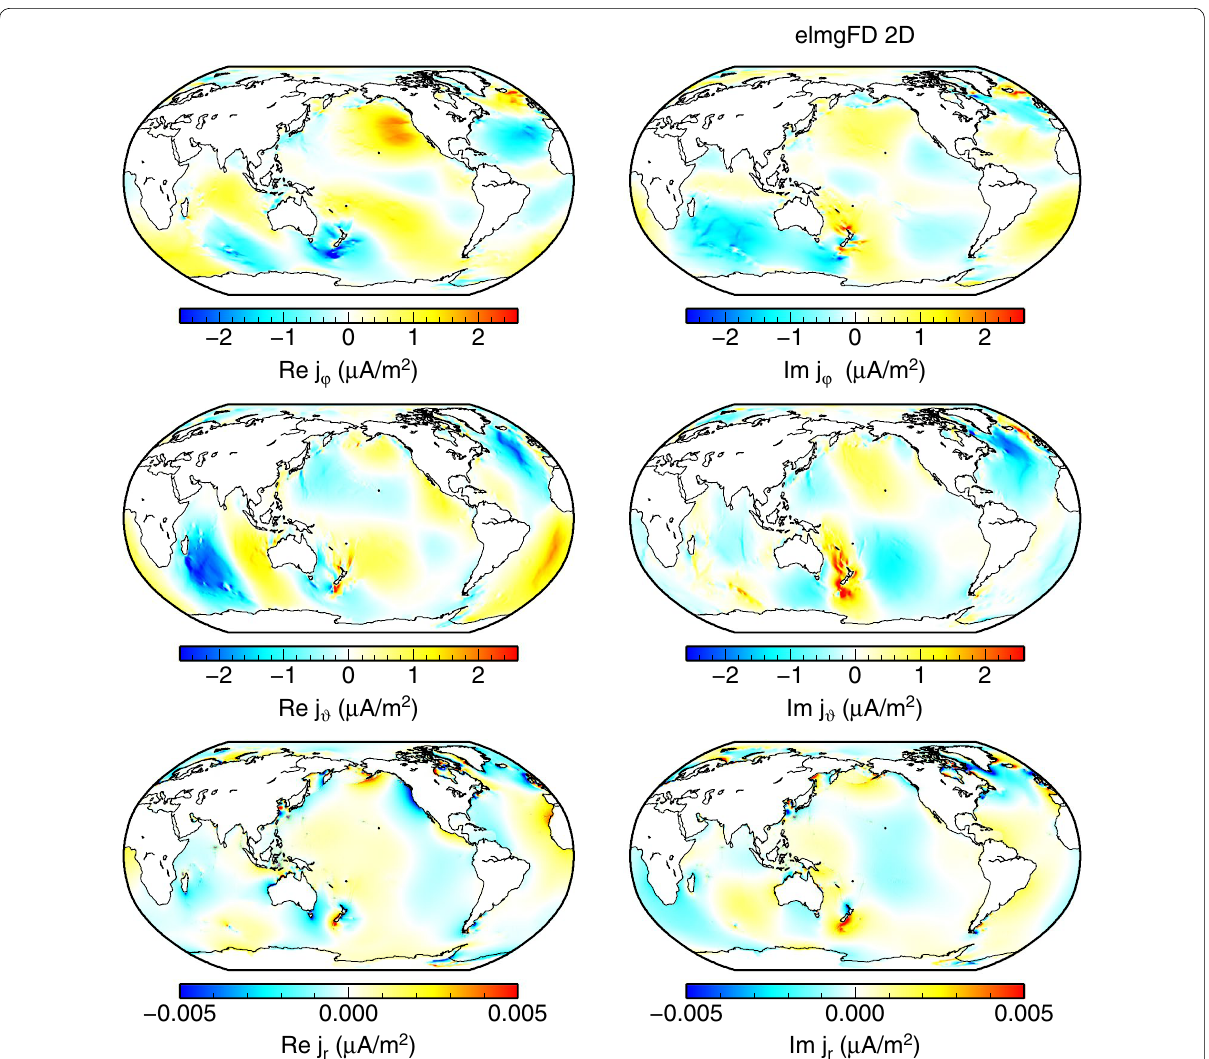
Fig. 11 Electric current density at the seafloor. The eastward, southward, and radial components of the 2-D elmgFD solution at j max = 480 are shown, respectively, from top to